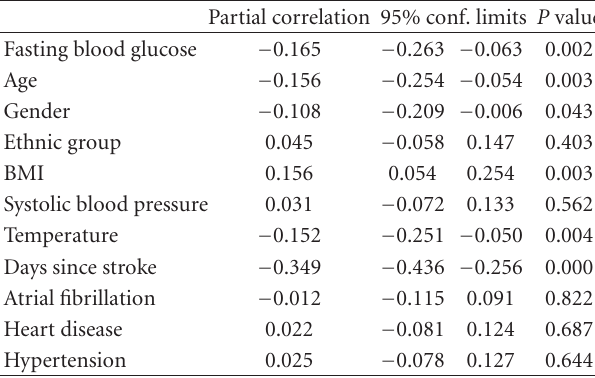
Table 2: Variables associated with admission stroke severity (FIM) linear-regression model parameters ∗